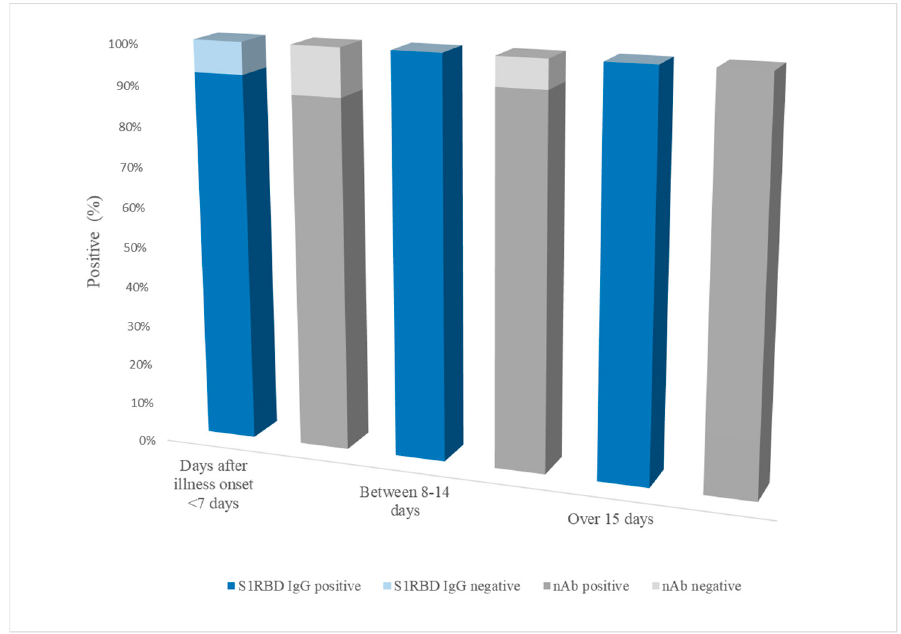
Figure 2. Sensitivity (%) of the RapiSure COVID-19 S1 RBD IgG/Neutralizing Ab Test in three groups: <7 days, 8–14 days, and >15 days after onset of illness. Blue bars represent the results for S1 RBD IgG; gray bars represent the results for nAbs, of which each upper light-colored bar represents a false negative result.